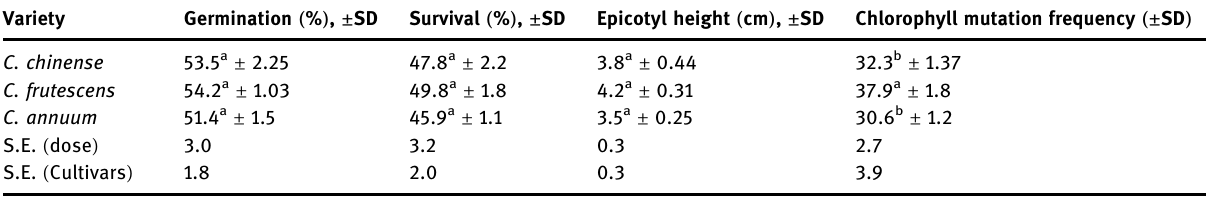
Table 3: Pepper varietal mean trait performance across gamma irradiation doses